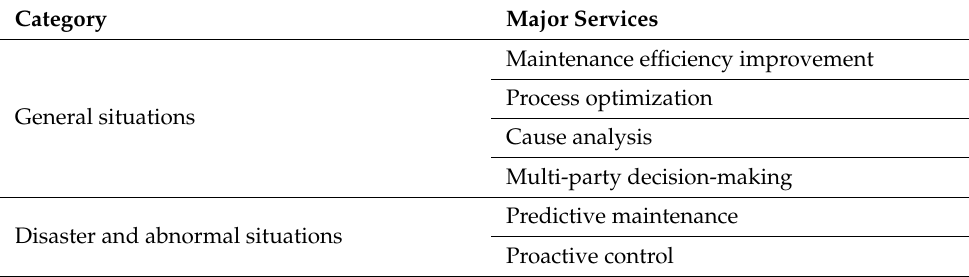
Table 2. Distinction between service types using a digital